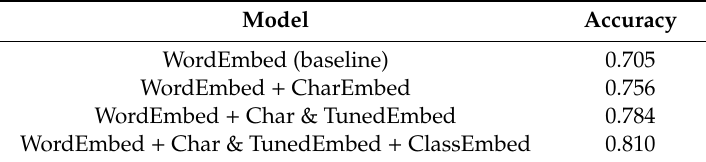
Table 2. Performance changes according to the use of embedding